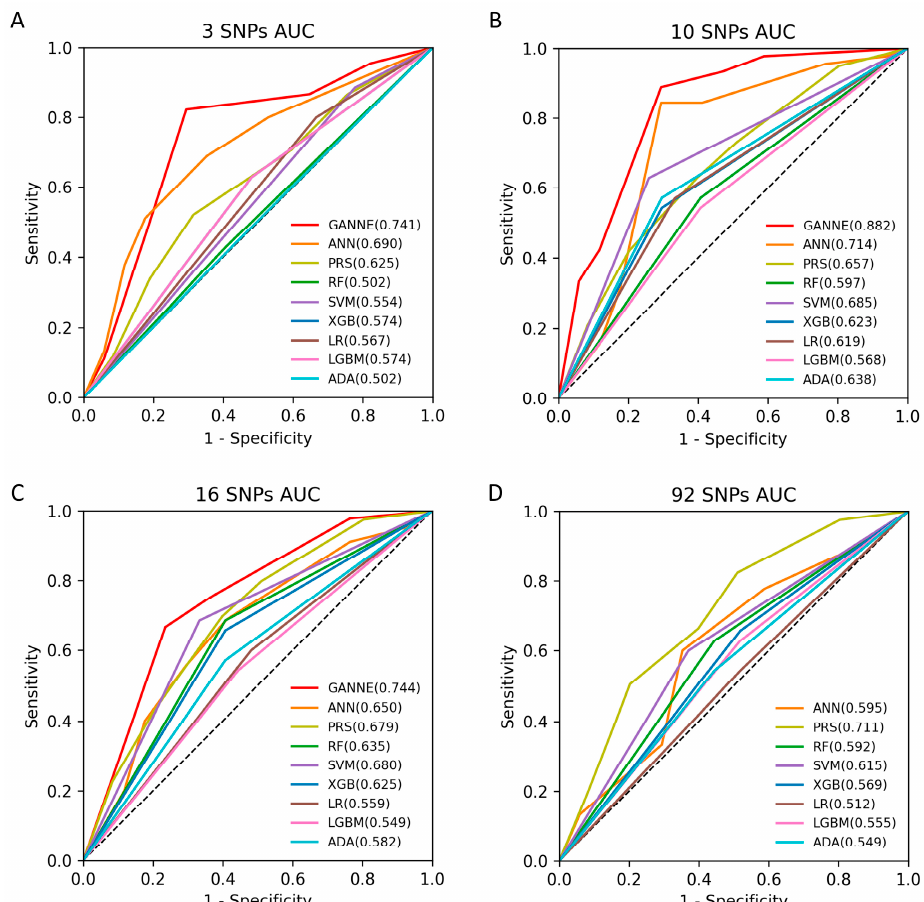
Figure 1. Comparison of predictive power by using nine models for nonsyndromic cleft lip with or without cleft palate risk. Model performance was measured by the area under the receiver operating curve (AUC) for each risk model in four different sets of single nucleotide polymorphisms (SNPs). ( A ) models trained on 3 SNPs with p < 0.01, ( B ) models trained on 10 SNPs with p < 0.05, ( C ) models trained on 16 SNPs with p < 0.1, and ( D ) models trained on all 92 SNPs. ADA, adaptive boosting; GANNE, genetic-algorithm-optimized neural networks ensemble; ANN, artificial neural network; PRS, polygenic risk score; RF, random forest; SVM; support vector machine; XGB, extreme gradient boosting; LR, logistic regression; LGBM, light gradient boosting model.